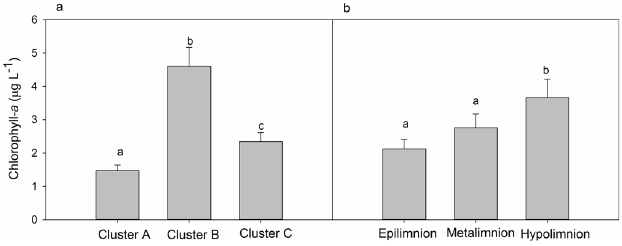
comparisons of ln-transformed data.